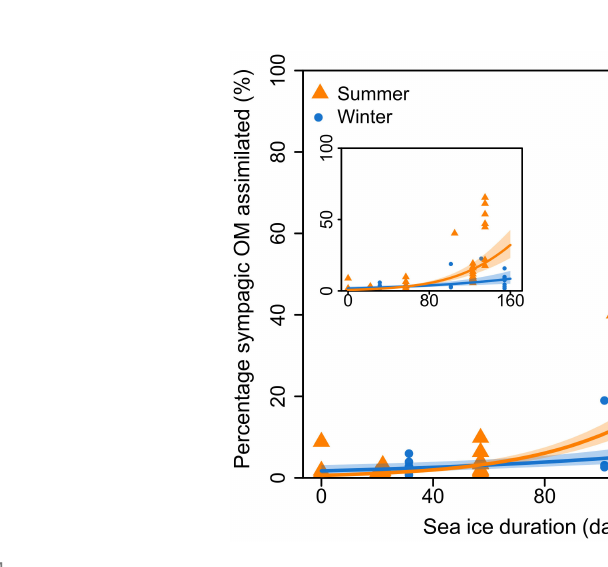
FIGURE 4 Proportion of sympagic organic matter (OM) assimilated based on the H-print approach against sea ice duration for stations south of 79°N. Samples are separated according to season, with orange triangles representing summer, and blue circles representing winter. Lines and shaded areas respectively represent regressions on logit-transformed data and 95% con fi dence intervals for each season. Inset shows the same graph, but with only stations south of 78°N.